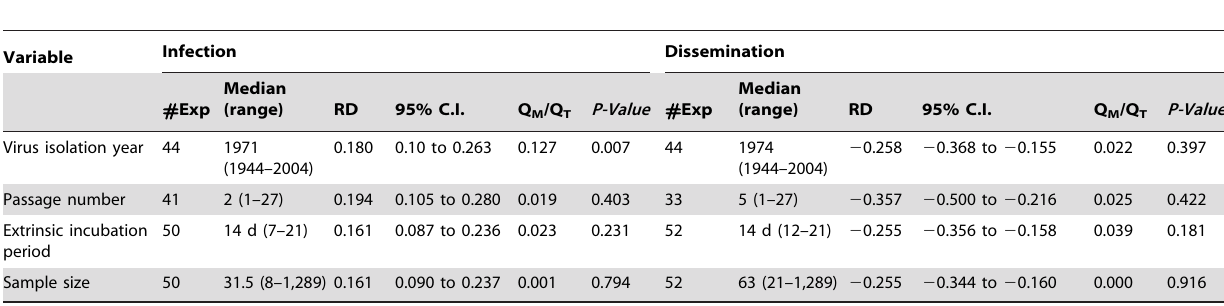
Table 2. Influence of continuous variables on the relative oral susceptibility to DENV of Ae. albopictus compared to Ae. aegypti measured by the rate of midgut infection and the rate of virus dissemination from the